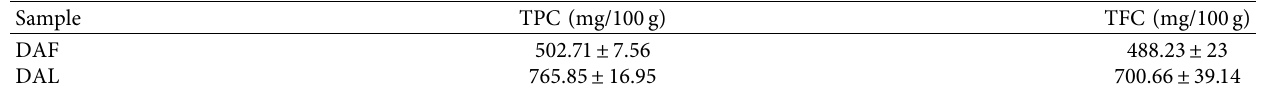
Table 7: Total phenol and total favonoid content for the fower and leaf